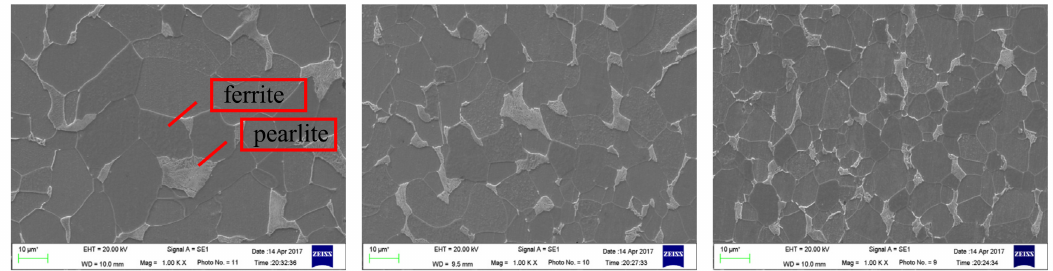
Figure 9. Microstructures of rolled strips for ( a ) non-lubricant; ( b ) traditional lubricating fluid and ( c ) nano-TiO 2 lubricating fluid.